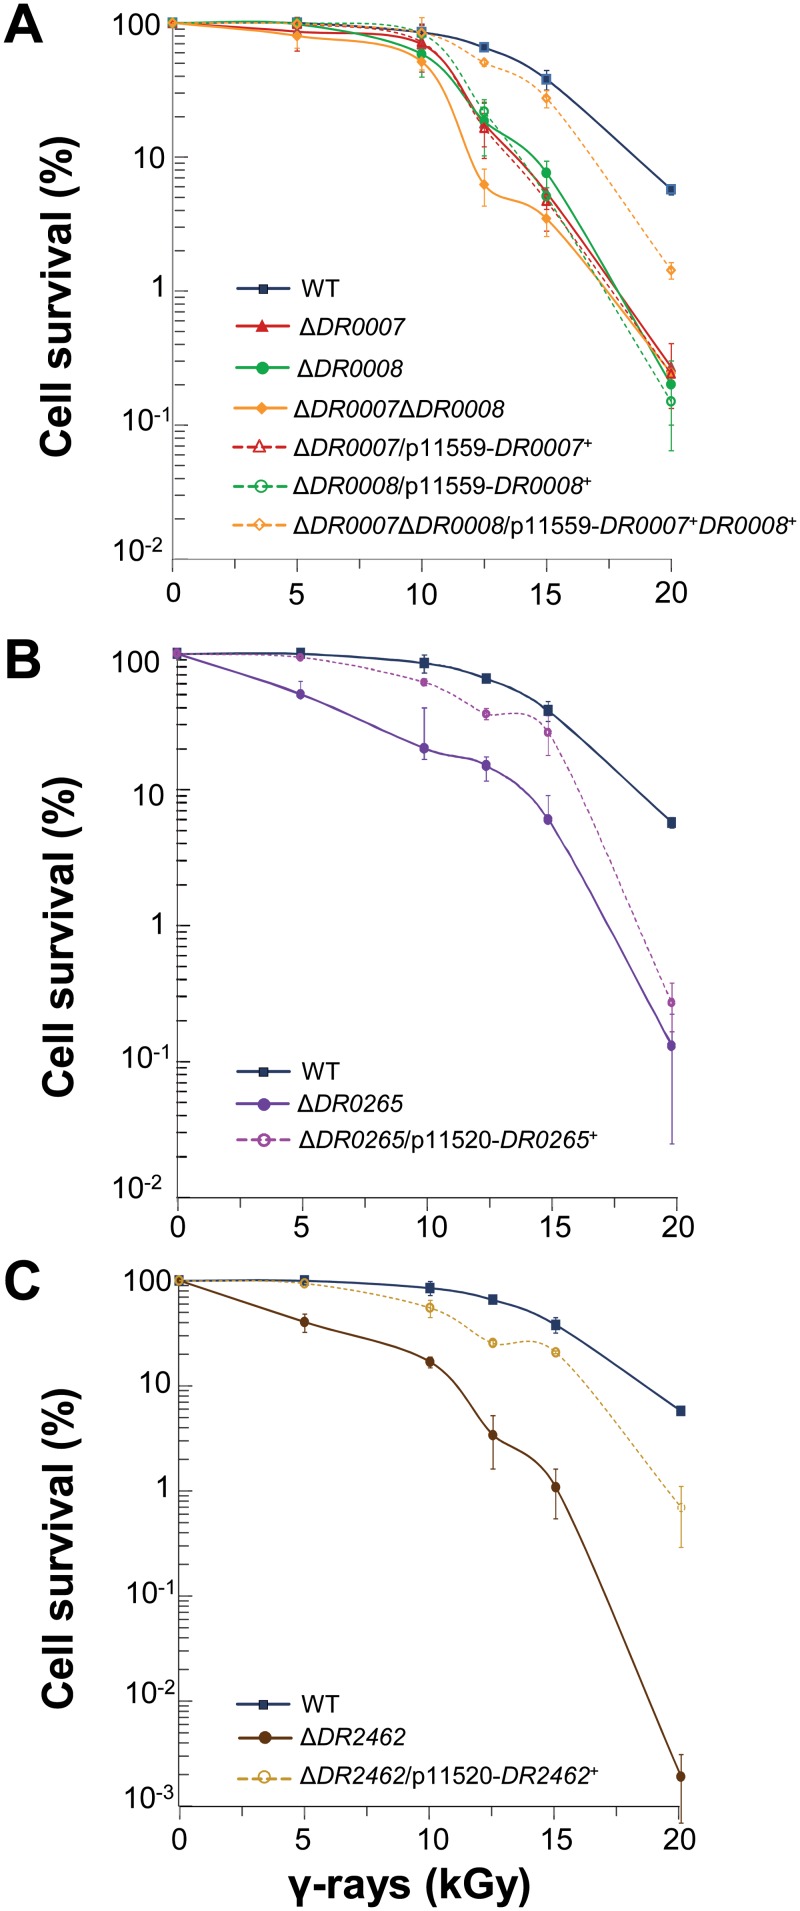
The D. radiodurans mutants deleted for DR0007, DR0008 or both (A), DR0265 (B) and DR2462 (C) show increased sensitivity to γ-irradiation.Bacteria were exposed to γ-irradiation at doses indicated on the abscissa. Symbols: (A) wild-type (blue squares), ΔDR0007 (red closed triangles), ΔDR0008 (green closed circles), ΔDR0007ΔDR0008 (yellow closed diamonds), ΔDR0007/p11559-DR0007
+ (red open triangles), ΔDR0008/p11559-DR0008
+ (green open circles), ΔDR0007 ΔDR0008/p11559-DR0007
+
DR0008
+ (yellow open diamonds). (B) wild-type (blue squares), ΔDR0265 (purple closed triangles), ΔDR0265/p11520-DR0265
+ (pink open triangles). (C) wild-type (blue squares), ΔDR2462 (brown closed circles), ΔDR2462/p11520-DR2462
+ (ochre open circles).